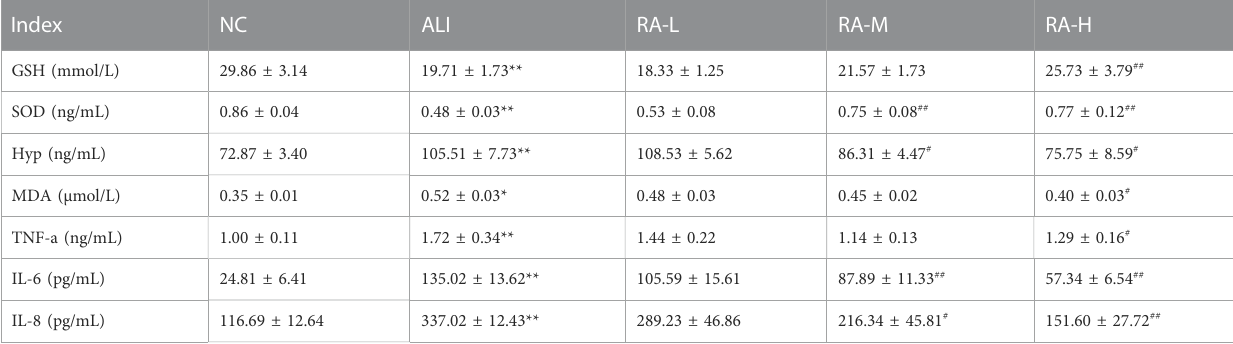
TABLE 3 The effects of rhubarb anthraquinone on liver biochemical indices in rats with acute liver injury (Mean ± s